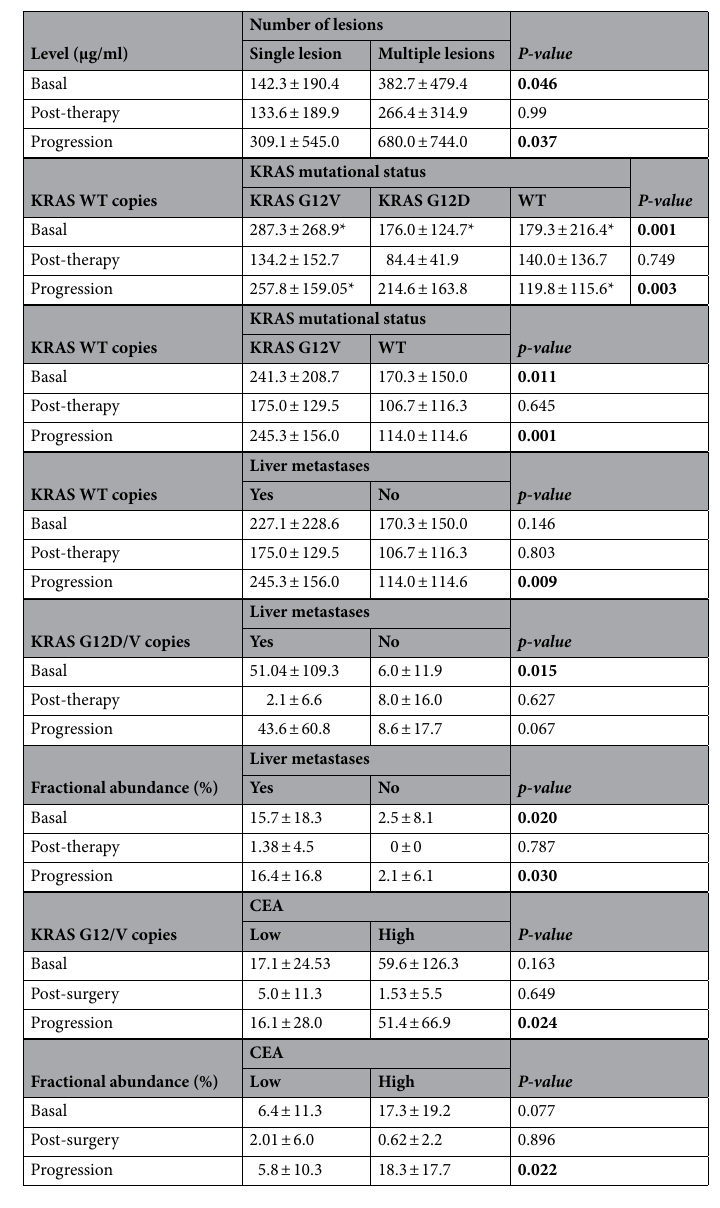
Table 3. Correlation between exosomes level, KRAS copies and clinical-pathological characteristics in metastatic CRC